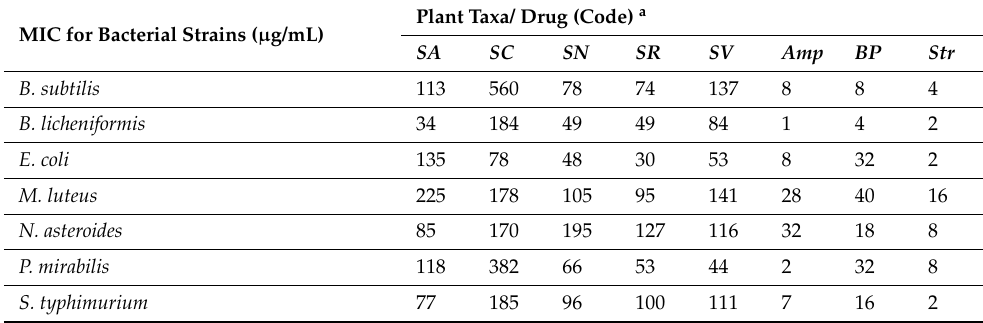
Table 1. MIC values of different taxa of the S. nigrum complex for the analyzed bacteria. MIC for Bacterial Strains ( µ